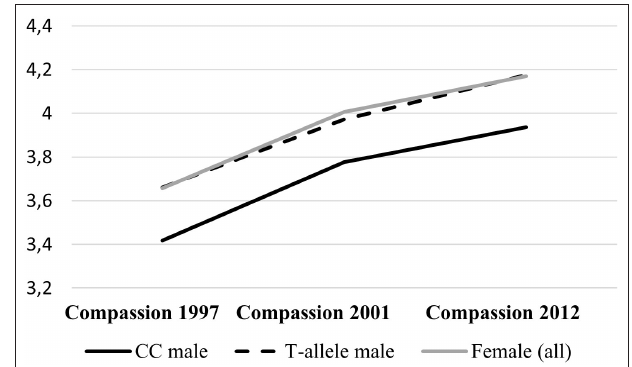
FIGURE 1 | Development of dispositional compassion for others over time. Comparing female participants ( n = 1,192; gray line) with male participants split by DBH rs1611115 genotype. Continuous black line are CC homozygotes ( n = 646), and dotted black line are carriers of the T-allele ( n = 292).